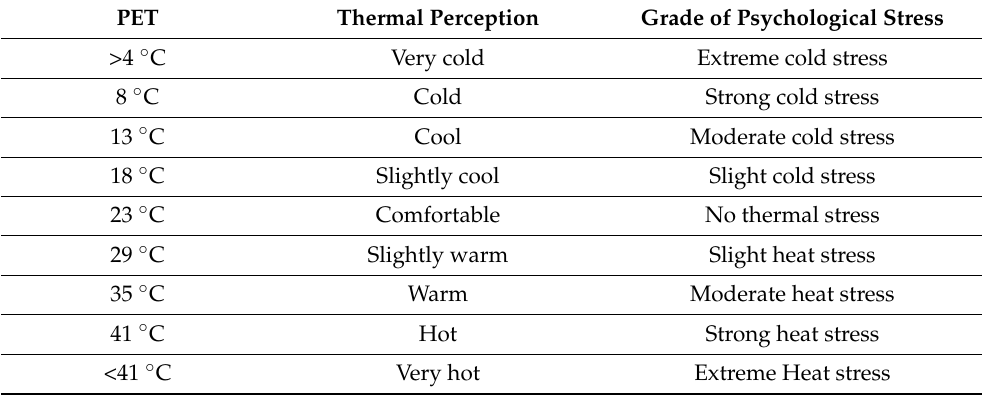
Table 1. Ranges of the physiological equivalent temperature (PET) for different grades of thermal perception by human beings and physiological stress on human beings; internal heat production: 80 W, heat transfer resistance of the clothing: 0.9